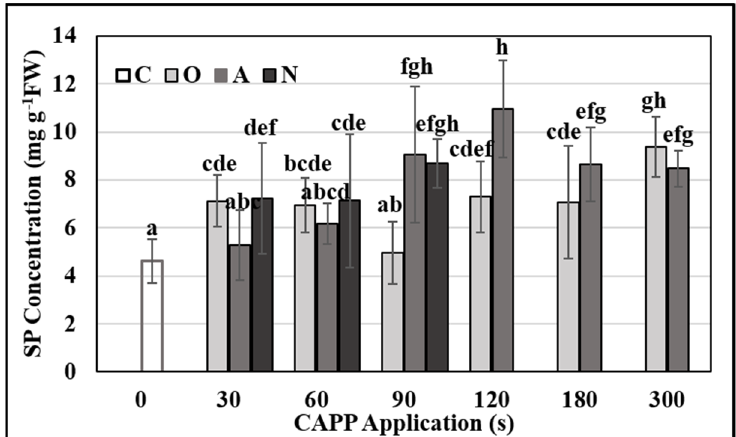
Figure 4. Total soluble protein (SP) concentration in 3-day-old maize seedlings after Cold Atmospheric Pressure Plasma (CAPP) treatment of grains. Variants: C—control/untreated maize grains; O30 ‒ O300: maize grains treated with plasma generated in an oxygen atmosphere for 30, 60, 90, 120, 180 or 300 s; A30 ‒ A300: maize grains treated with plasma generated in ambient air for 30, 60, 90, 120, 180 or 300 s; N30 ‒ N300: maize grains treated with plasma generated in a nitrogen atmosphere for 30, 60, 90, 120, 180 or 300 s. In the case of N120 ‒ 300 variants, the maize grains did not germinate, so they are not shown in the graph. Different letters indicate significant difference at p -value < 0.05, bars are means of ten experimental runs (one run represents 50 grains per variant; three 1.5 g mixed samples were analyzed per one experimental run and each variant for soluble protein concentration) ± SD according to LSD ANOVA test.